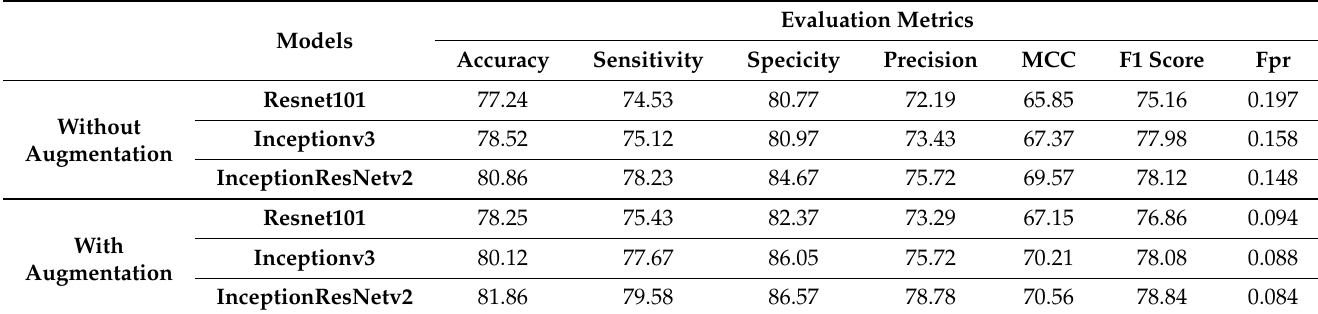
Table 3. Results for pre-trained models using dataset